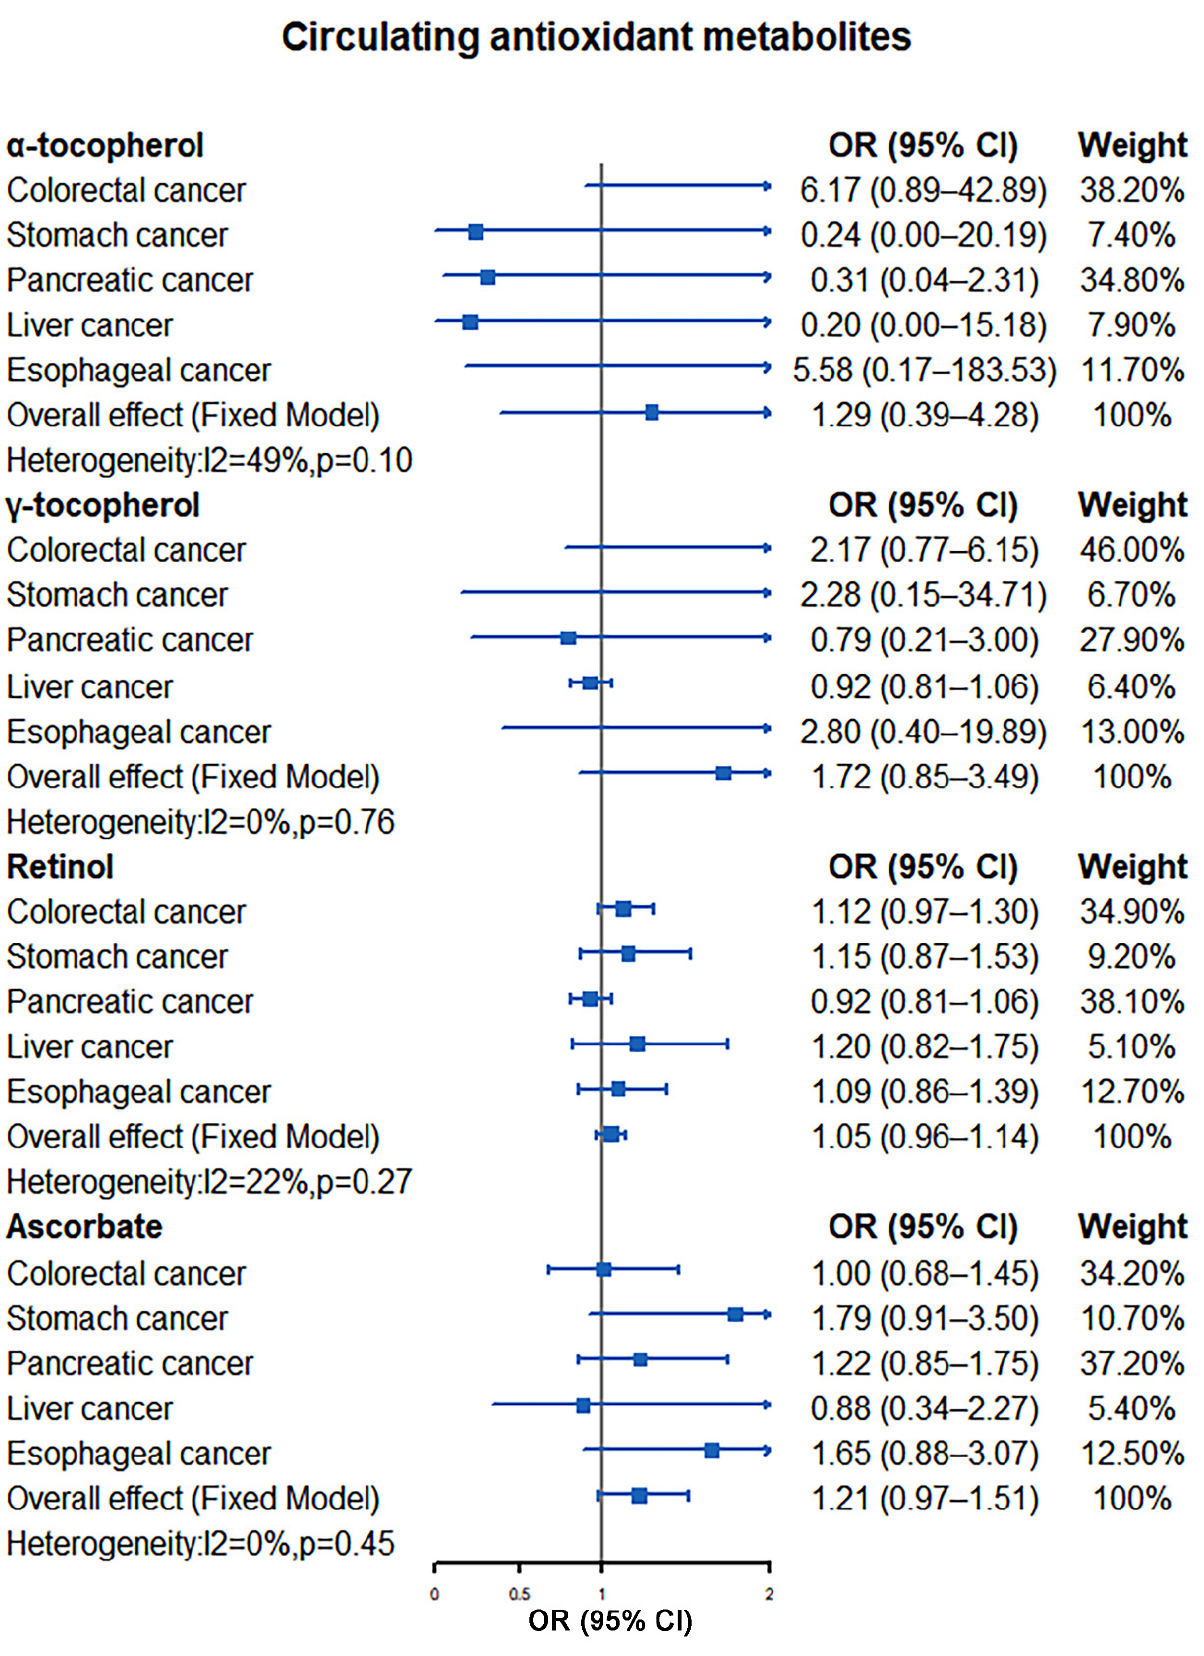
Figure 3. Causal association between circulating antioxidant metabolites with digestive system tu-